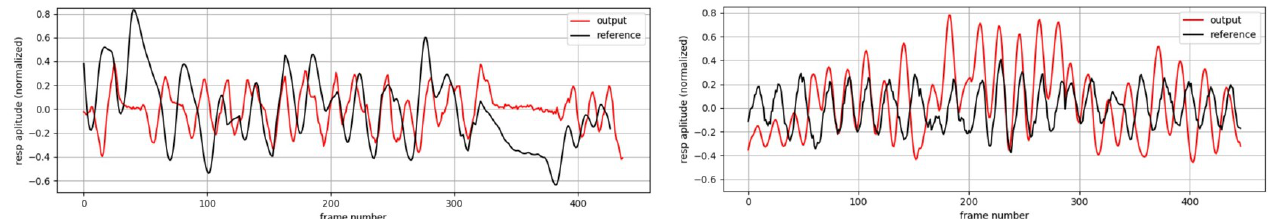
Figure 13. Comparison of the calculated respiration signal to the reference. Due to body motion and the applied filters in both the reference calculation and the introduced method, the phase of the signals changes, but the number of the peaks are well kept, resulting in MAE: 0.5494, RMSE: